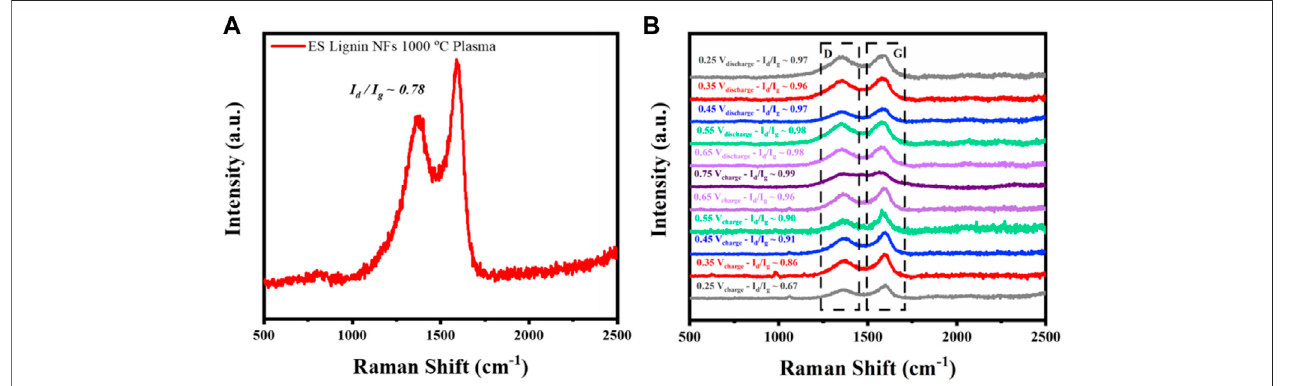
FIGURE 6 | (A) Ex-situ and (B) in-situ Raman spectra recorded under electrochemical potentiostatic conditions between 0.25 and 0.75 V ( Δ Ε = 0.1